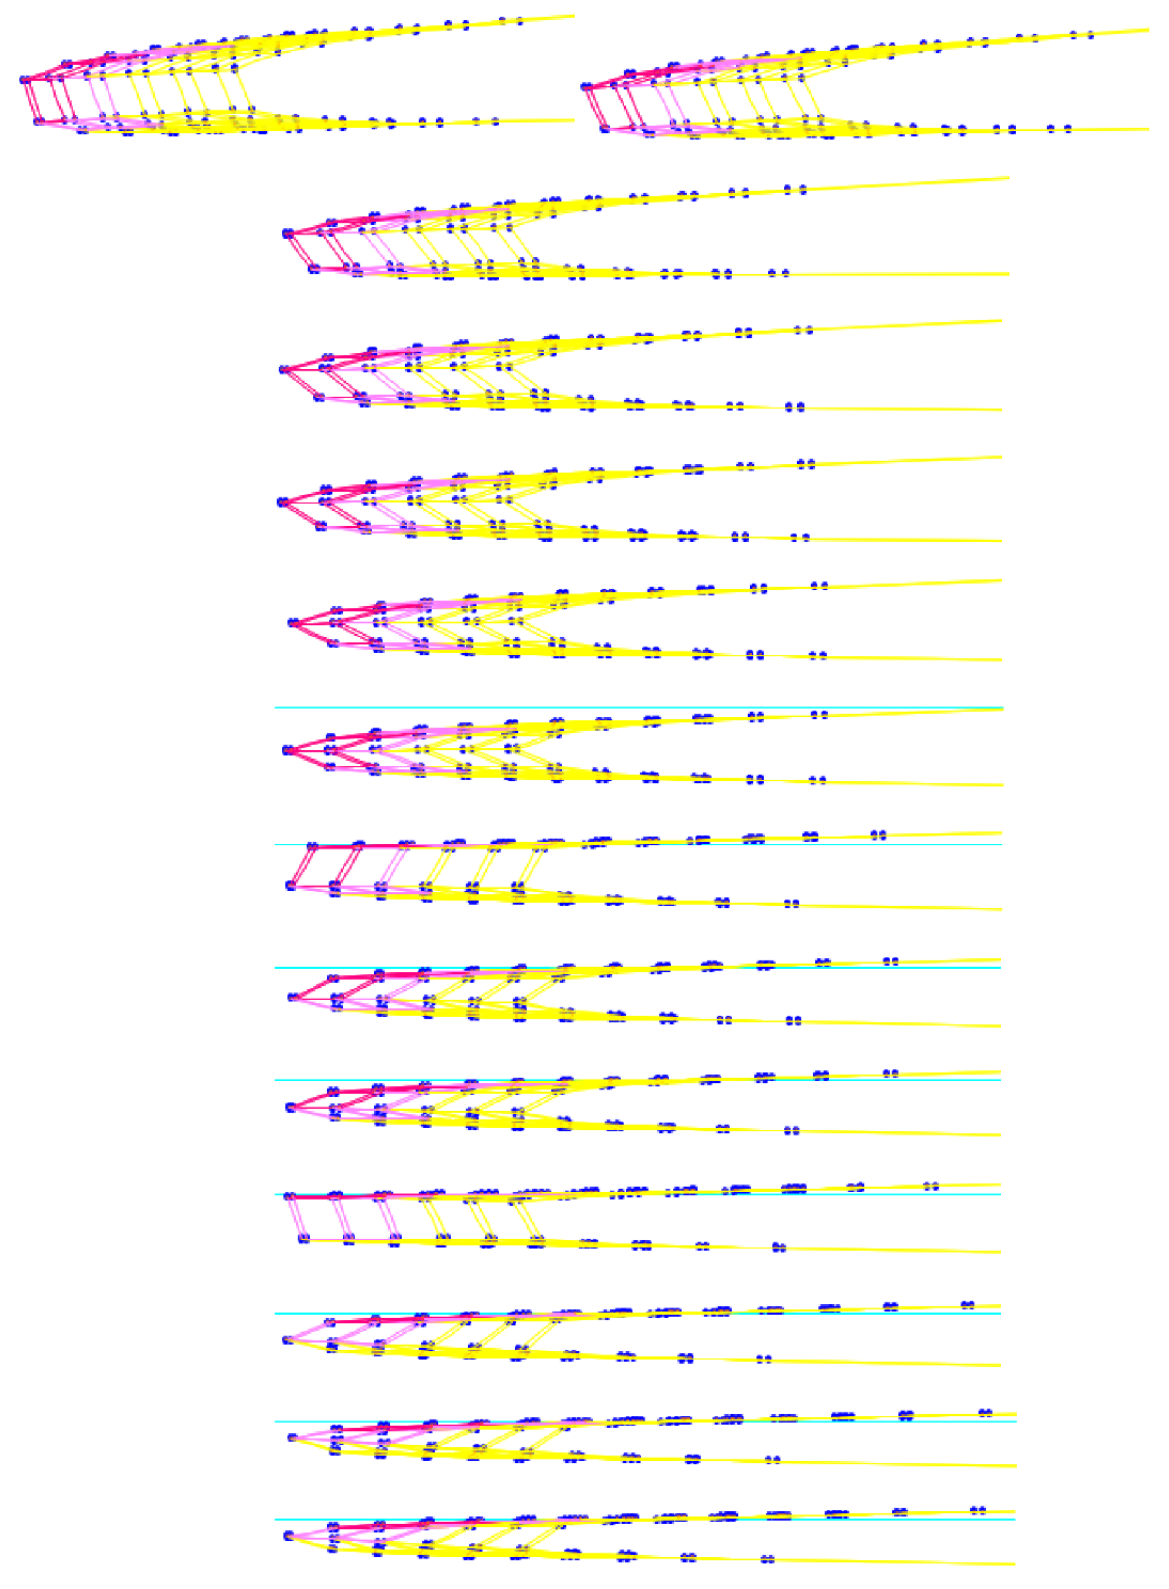
Figure 35. Shape changes of the flexible trawl in straight-line towing at v = 4 m/s.